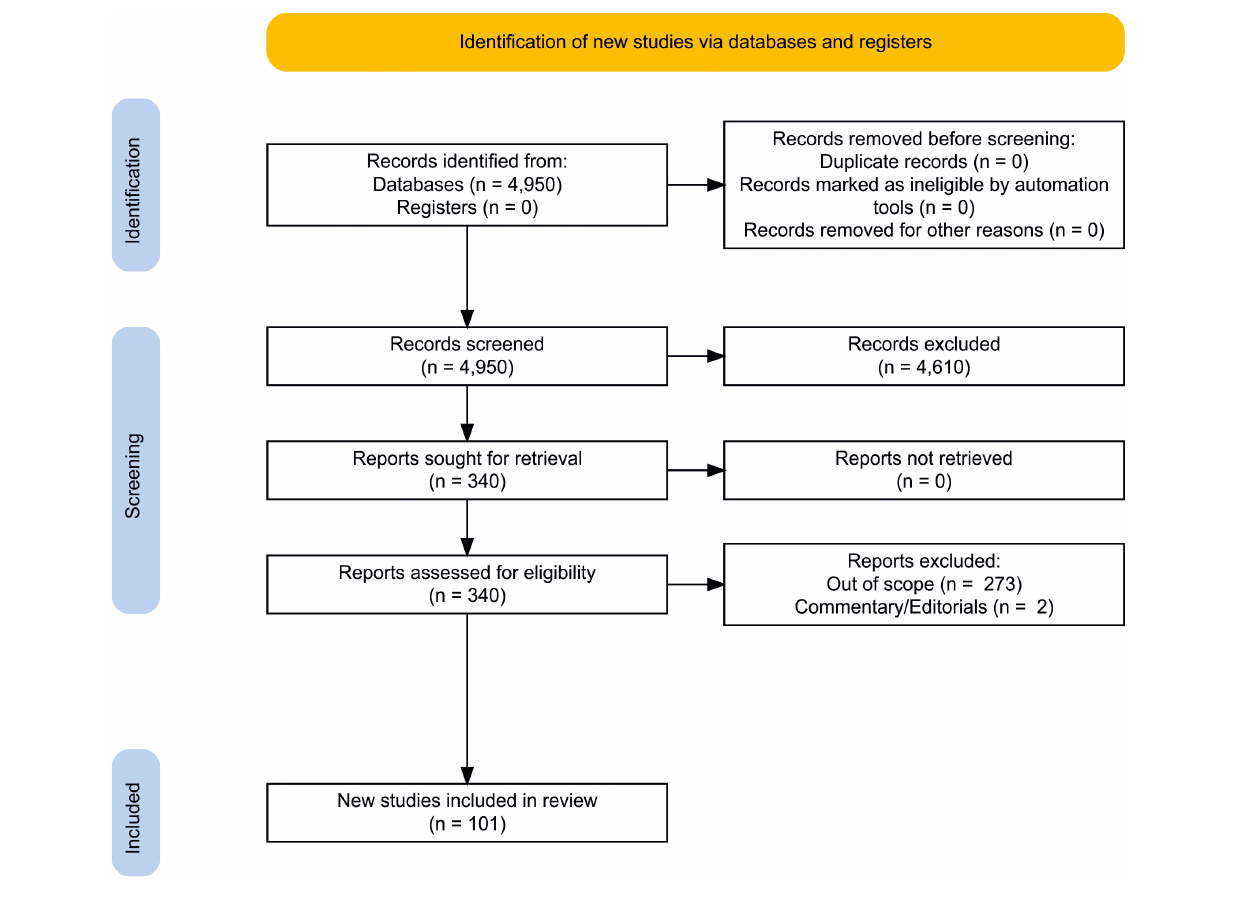
expression of TLR4 and TLR5 in PBMCs was found in drug-naive patients (27). TLR4 expression returned to normal after treatment. Generally, further studies of changes in TLRs expression on various immune cells and their functional activity in schizophrenia are needed.